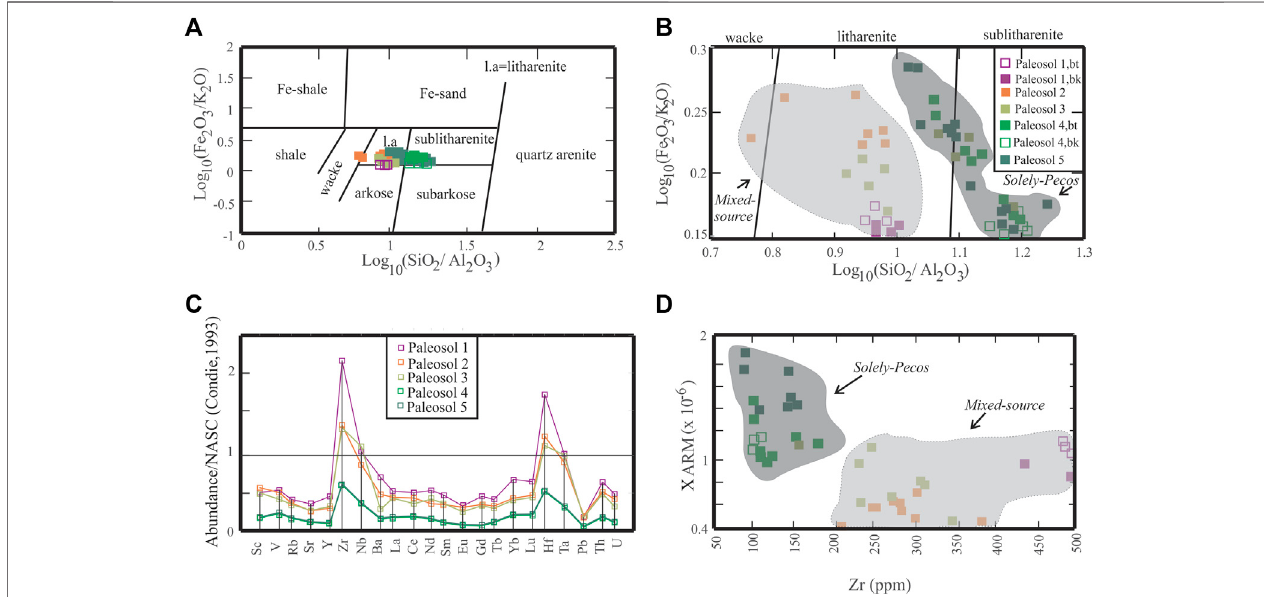
FIGURE 13 | Comparing the geochemical and rock-magnetic data set from (Stine et al., 2020) in order to determine change in provenance. Figure 13A,B are log10(Fe The few Paleosol 3 data-points that plot in the solely-Pecos region are from the basal-most section of the unit, and potentially represent a transitional zone from Paleosol4to3. Figure13C showsaspider-diagramofselecttraceelementconcentrationsnormalized totheNorthAmericanShaleComposite(NASC)(Condie,1993). NotehowPaleosols3-1havesubstantiallyhigherconcentrationsofZr,Nb,Hf,andTa,implyingdifferentprovenance(ParkerandFleischer,1968;Armstrong-Altrinetal., 2013; Nagarajan et al., 2016; Stine et al., 2020). Figure 12D is a cross-plot of χ ARM vs the Zr concentration, note how the clustering of solely-Pecos and mixed-source sediments, similar to Figure 13B . This implies that the change in provenance is partly responsible for the change in magnetic properties.